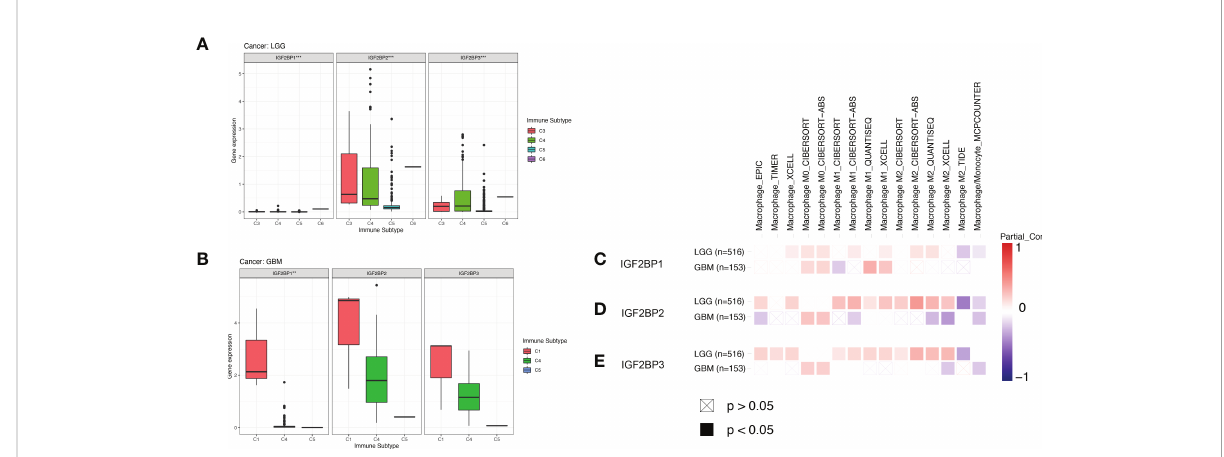
FIGURE 7 Association of IGF2BPs and tumor immune microenvironment in LGG and GBM based on TCGA. Association of the IGF2BPs expression and the immune in fi ltrate subtypes in (A) LGG and (B) GBM. (C-E) Association of the IGF2BPs expression and TAMs. Red color represents positive correlation, blue color represents negative correlation, and the deeper the color, the stronger the correlation. **P < 0.01, ***P < 0.001.